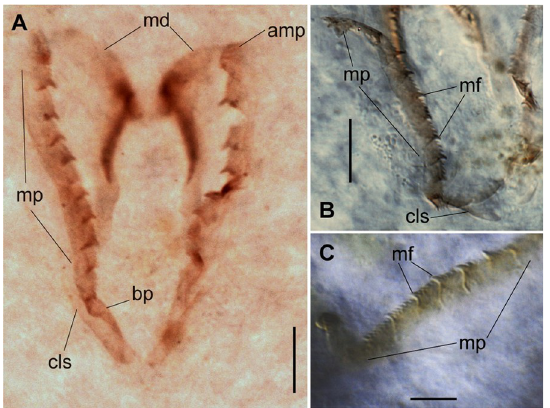
Fig 17. Meiodorvillea hartmanae sp. nov. (A) jaw apparatus; (B) maxillae; (C) maxillary plates; all dorsal view. Abbreviations: amp = anteriormost maxillary plates; bp = basal plate; cls = carrier-like structure; md = mandible; mf = main fang; mp = maxillary plates. Scale bars: (A,B) = 20 μ m; (C) = 10 μ